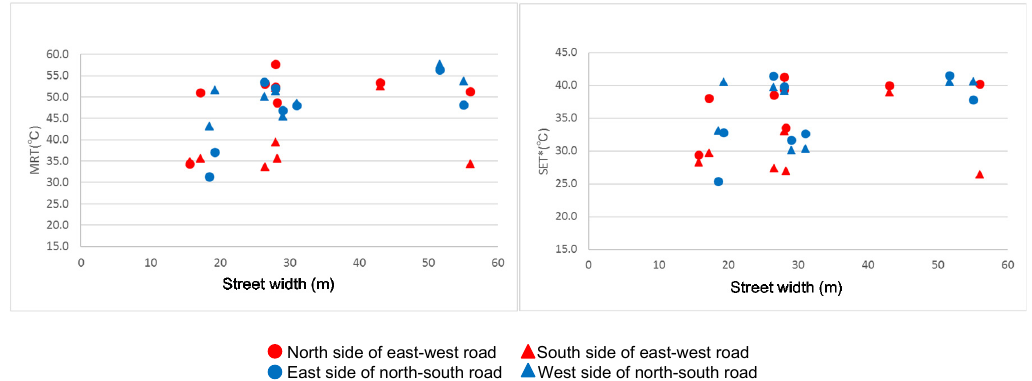
Figure 10. Measurement results of MRT (left) and SET* (right) at 1.5 m height around noon on 7 August 2019.